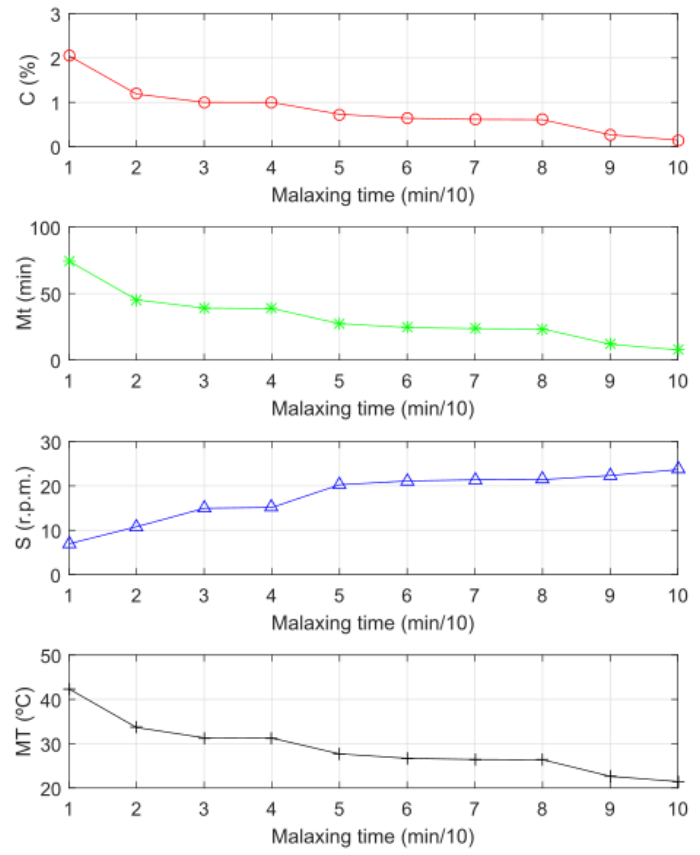
Figure 14. Outputs for different olive paste conditions.